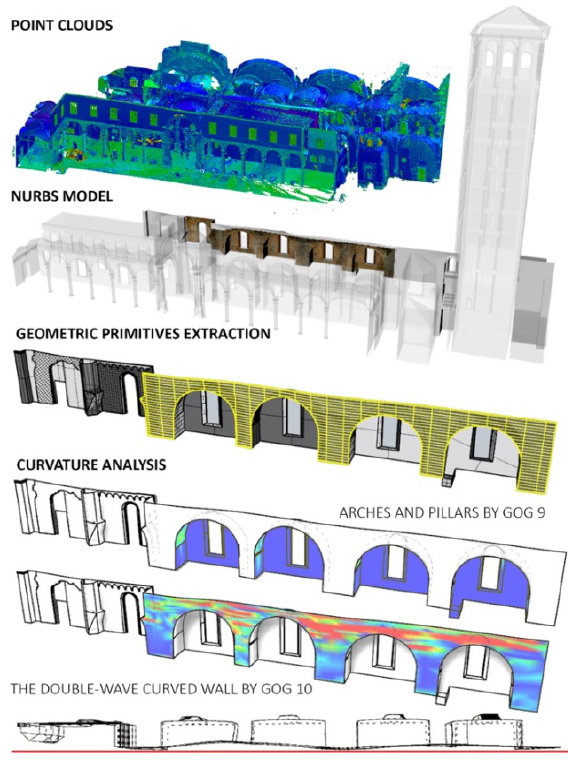
Figure 7. Building archaeology analysis applied to arch n.